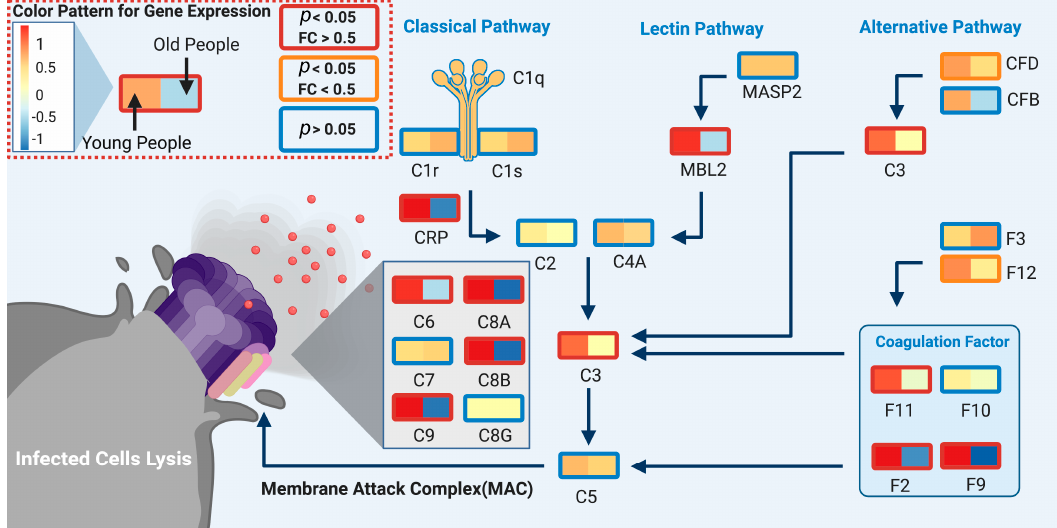
Figure 4. Differential expression of spleen complement system genes between male age groups. Boxes represent the mean gene expression value for the young (<60 years old; left) and the old (>60 years old; right) groups at spleen samples. Box line color indicates the significance level, red: p < 0.05 and fold change (FC) > 0.5; orange: p < 0.05 and FC > 0.5 and blue: p > 0.05 (not significant). The biological model indicates that multiple complement system and coagulation factor genes are more expressed in the younger than older male populations. Created with biorender.com.